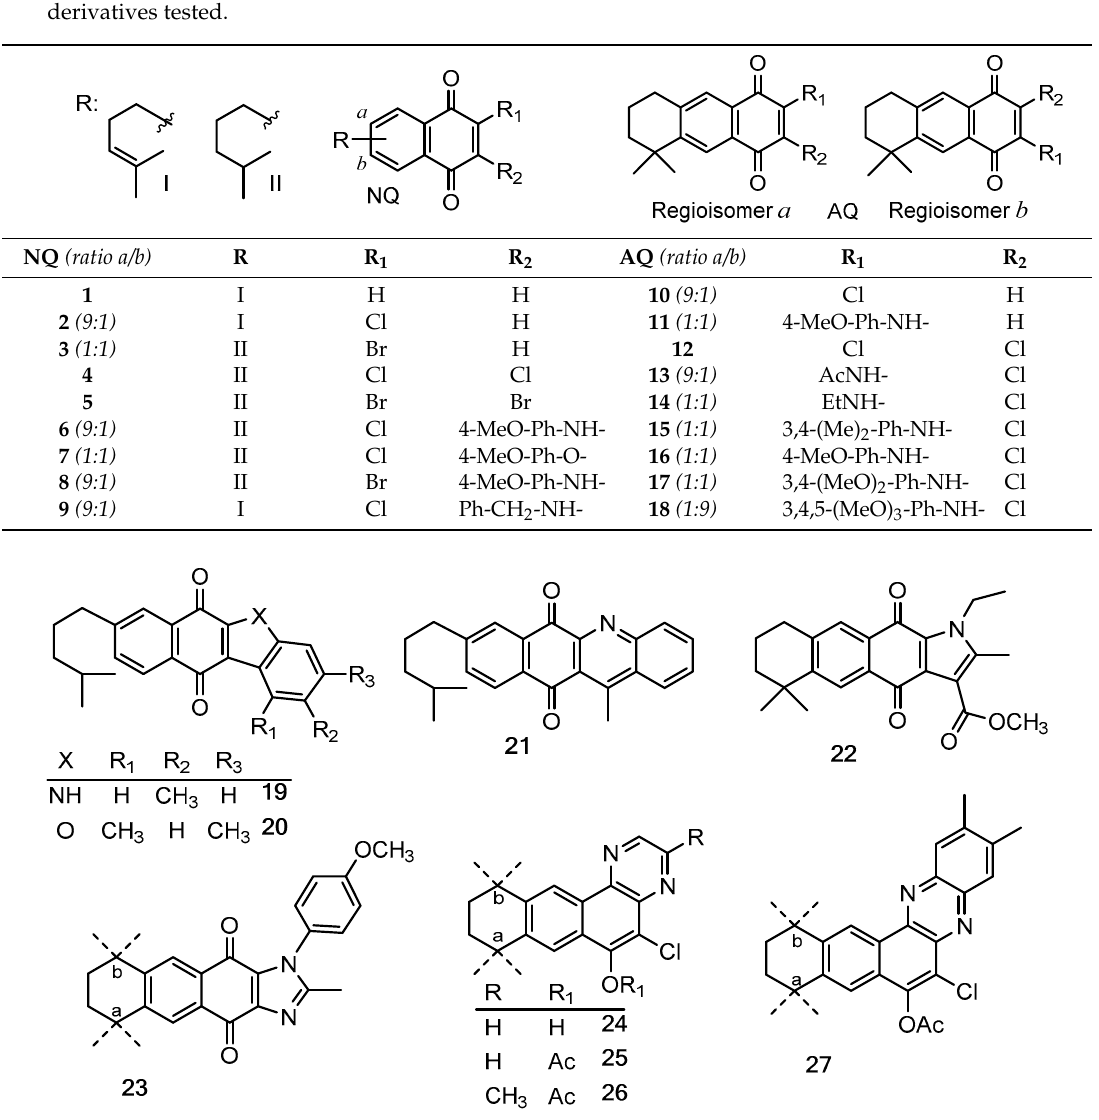
Figure 1. Chemical structures of the heterocycle-fused quinone derivatives (HetQs) tested. Compounds 23 – 27 are 1:1 mixtures of a and b regioisomers.